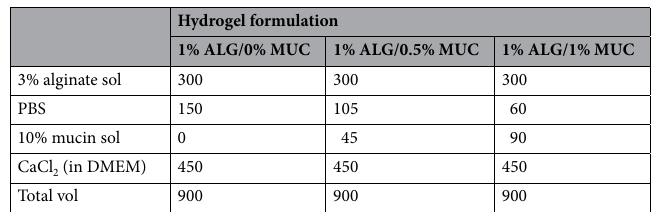
Table 1. Alginate and mixed alginate-mucin hydrogel volumes (μl) for 900 μl of hydrogel.